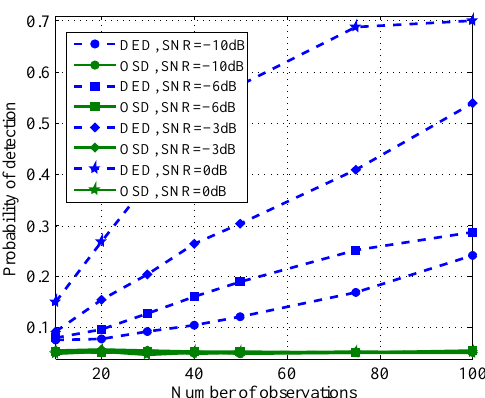
Figure 1. Probability of detection: DED and OSD for different M and SNRs | Gaussian primary signal | Nakagami-m fading: Shape parameter = 1 , Scale parameter = 0 . 5 .